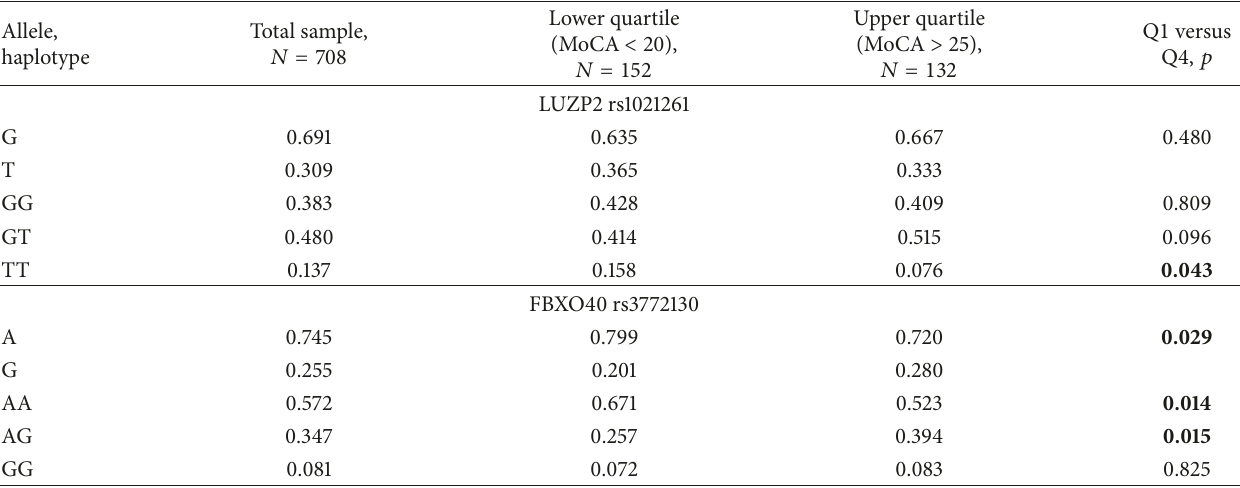
Table 2: Allele and genotype frequency of two genetic variants in LUZP2 and FBXO40 genes in the total sample and in the lower ( Q 1) and upper ( Q 4) quartiles of the MoCA distribution.